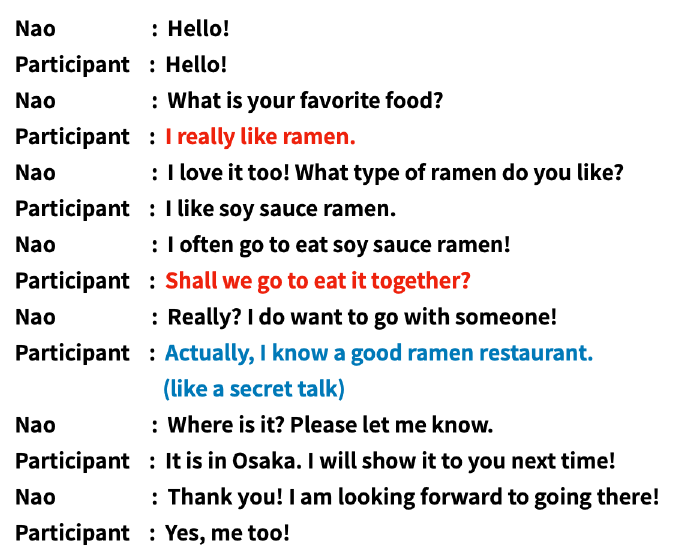
Figure 2. Sample of text showing colored lines. The participants were instructed to speak with positive and stronger emotion (negative emotion and sleepiness) when reading the red (blue)